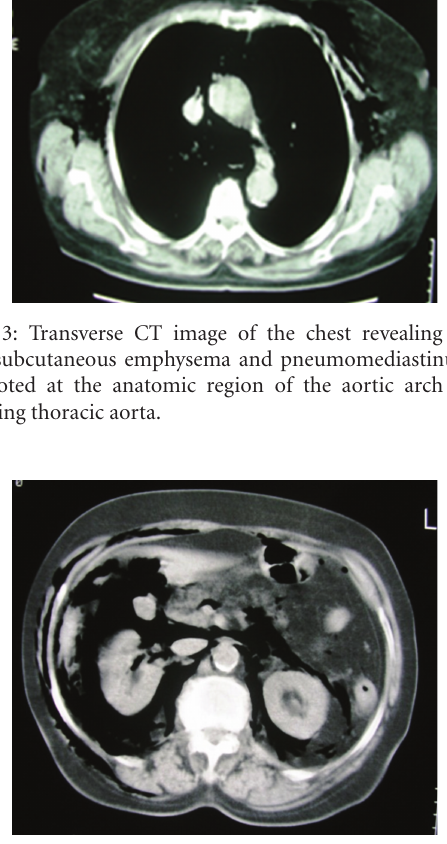
Figure 4: Transverse CT image of the upper abdomen demon- strating subcutaneous emphysema and pneumoperitoneum. Free air surrounds both kidneys and overlaps both great